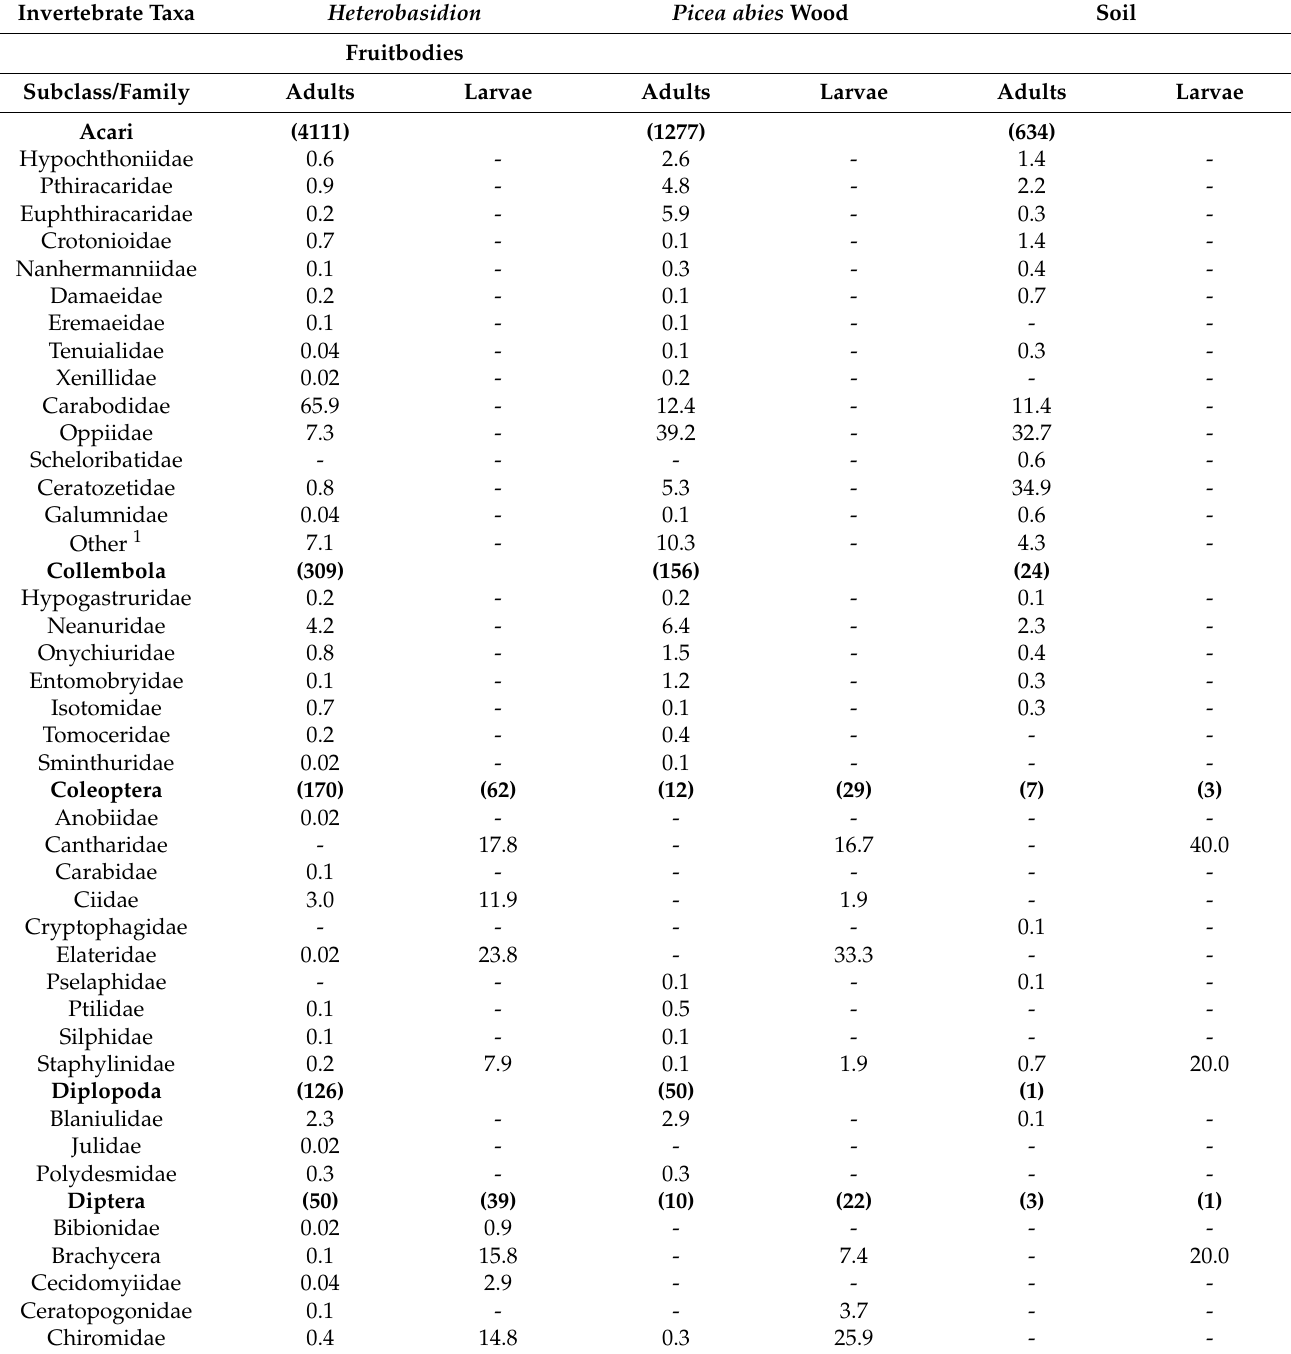
Table 1. Occurrence and relative abundance (%) of invertebrate taxa identified in Heterobasidion fruitbodies, Picea abies wood and soil samples. Absolute numbers for higher taxonomic groups are shown in